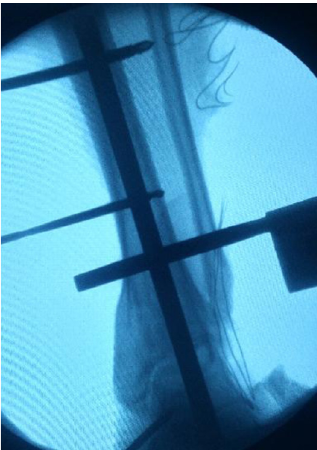
Figure 2. Alignment check. The pointer placed through the cutting guide must be parallel to the talar articular surface. The tibial alignment rod should be parallel to the mechanical axis of the tibia.